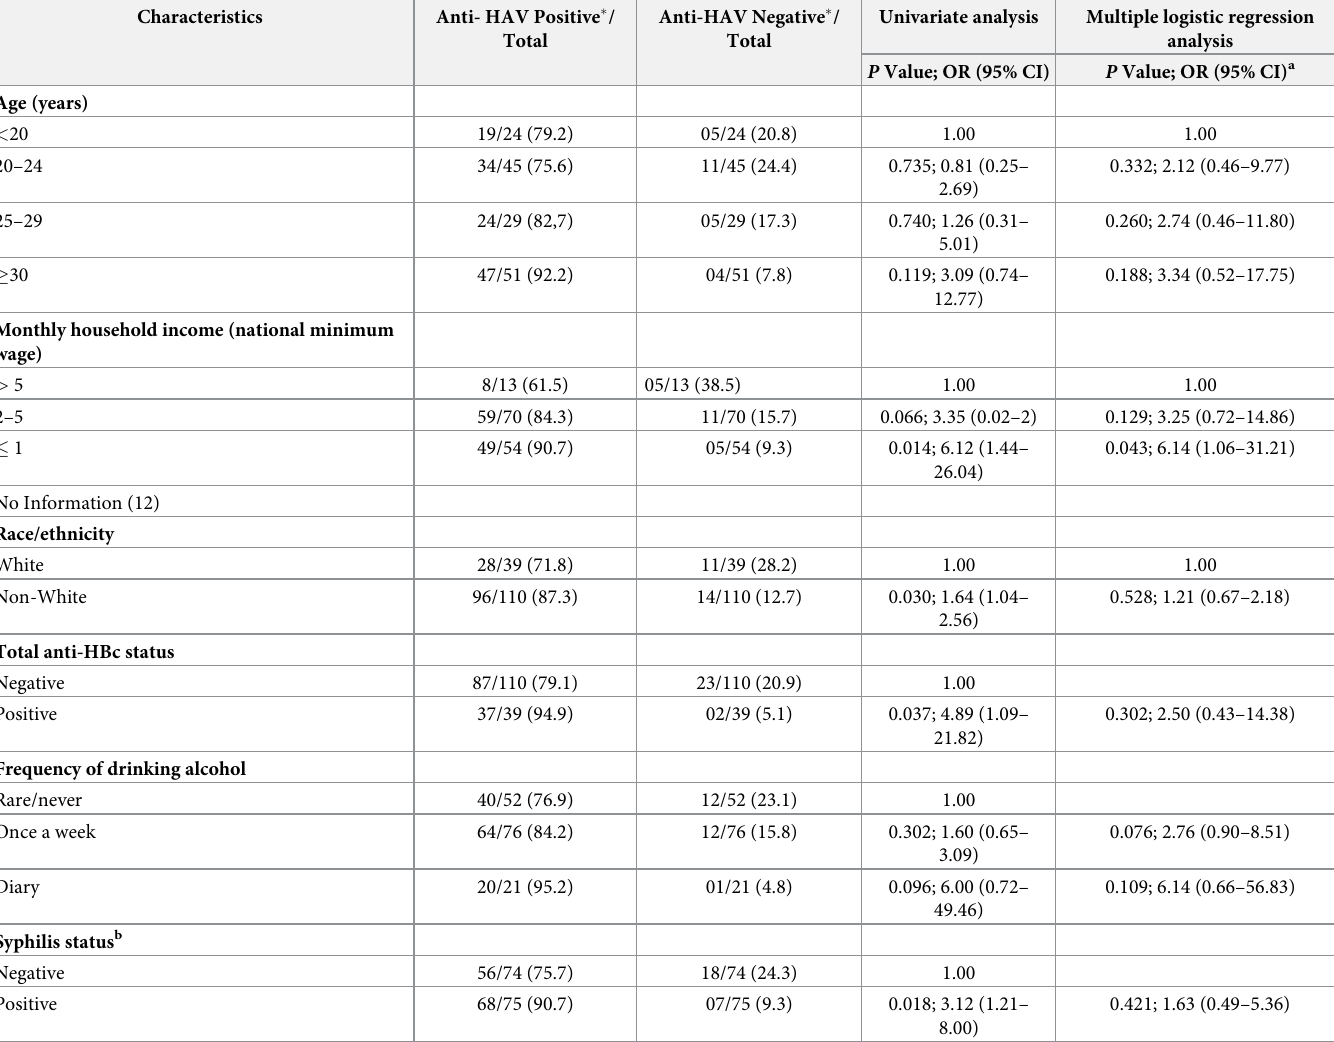
Table 2. Analysis of socio-demographic and behavioral characteristics among TW associated with positive anti-HAV antibodies (n = 149), Central Brazil.